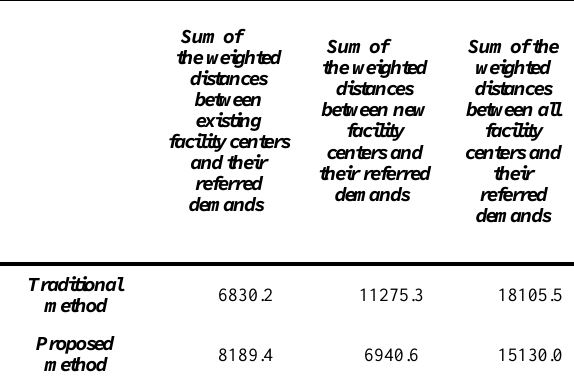
Table 3. Comparing the results of two